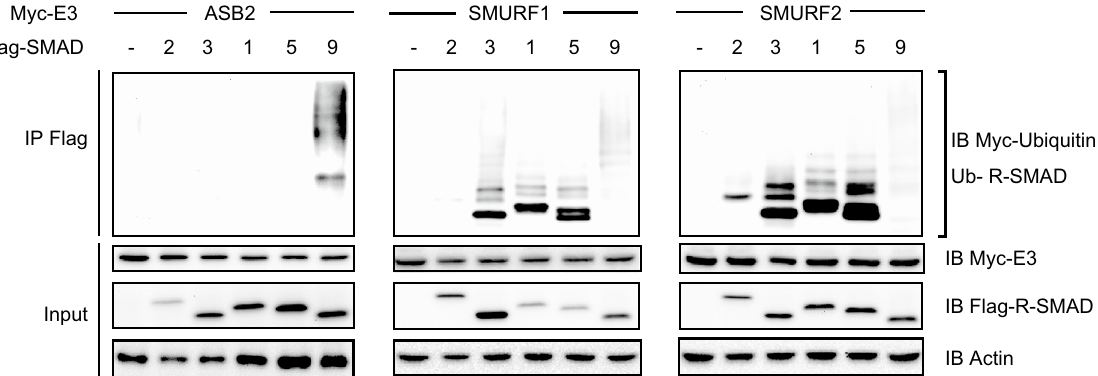
Figure 2. ASB2 specifically ubiquitylates SMAD9. HEK 293T cells were co-transfected with vectors coding HA-Ub, Myc-tagged E3 (Myc-ASB2, SMURF1 and SMURF2) and Flag-tagged R-SMADs (Flag-SMAD2, 3, 1, 5, 9) as indicated. Flag-immunoprecipitates or lysates were separated with SDS-PAGE and immunoblotted with the indicated antibodies. The cropped gel images were delineated and uncropped gel images are shown in the Supplementary